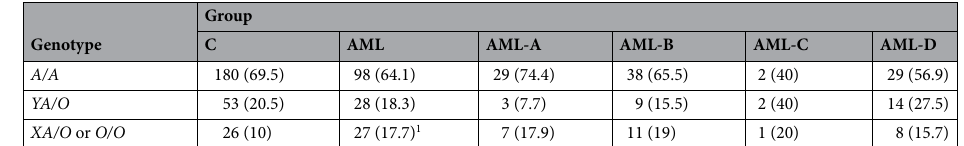
Table 3. Frequency of genotypes associated with selected MBL2 single nucleotide gene polymorphisms. Percentages are shown in parentheses. Allele distributions ( H/L, Y/X, A/D, A/B, A/C ) were in accordance with Hardy–Weinberg equlibrium. C: controls; AML-A: patients who experienced infections with proven bacteremia and/or fungaemia; AML-B: patients who experienced infections with no bacteremia; AML-C: patients who experienced febrile neutropenia; AML-D: patients who experienced none of afore-mentioned complications within 4 weeks of hospital stay. 1 p = 0.026, OR = 1.9, 95% CI (1.07–3.43) [multiple logistic regression, recessive model: p = 0.093, OR = 1.77, 95% CI (0.91–3.44)].